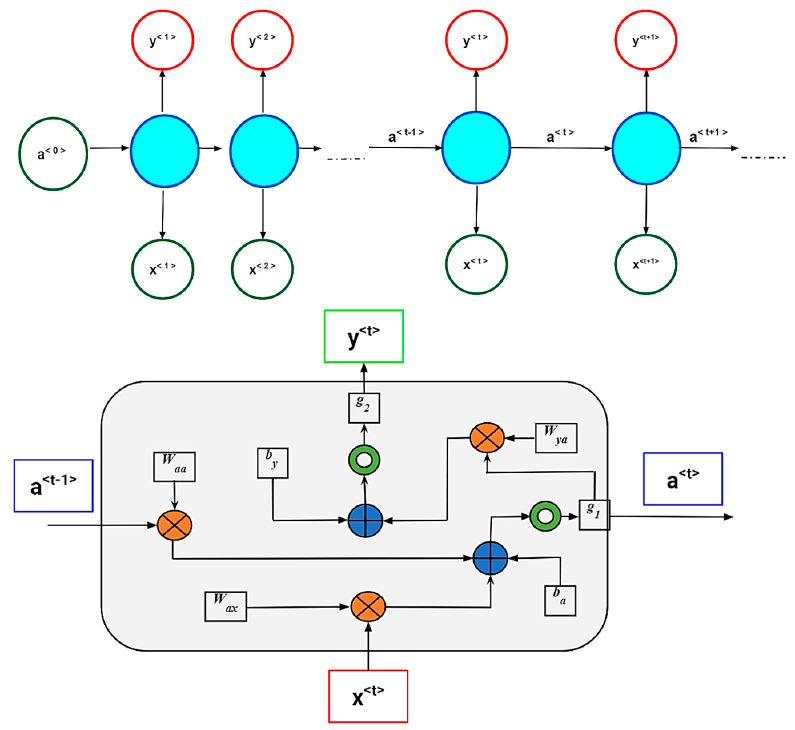
Figure 4. Schematic of the recurrent neural network (RNN).